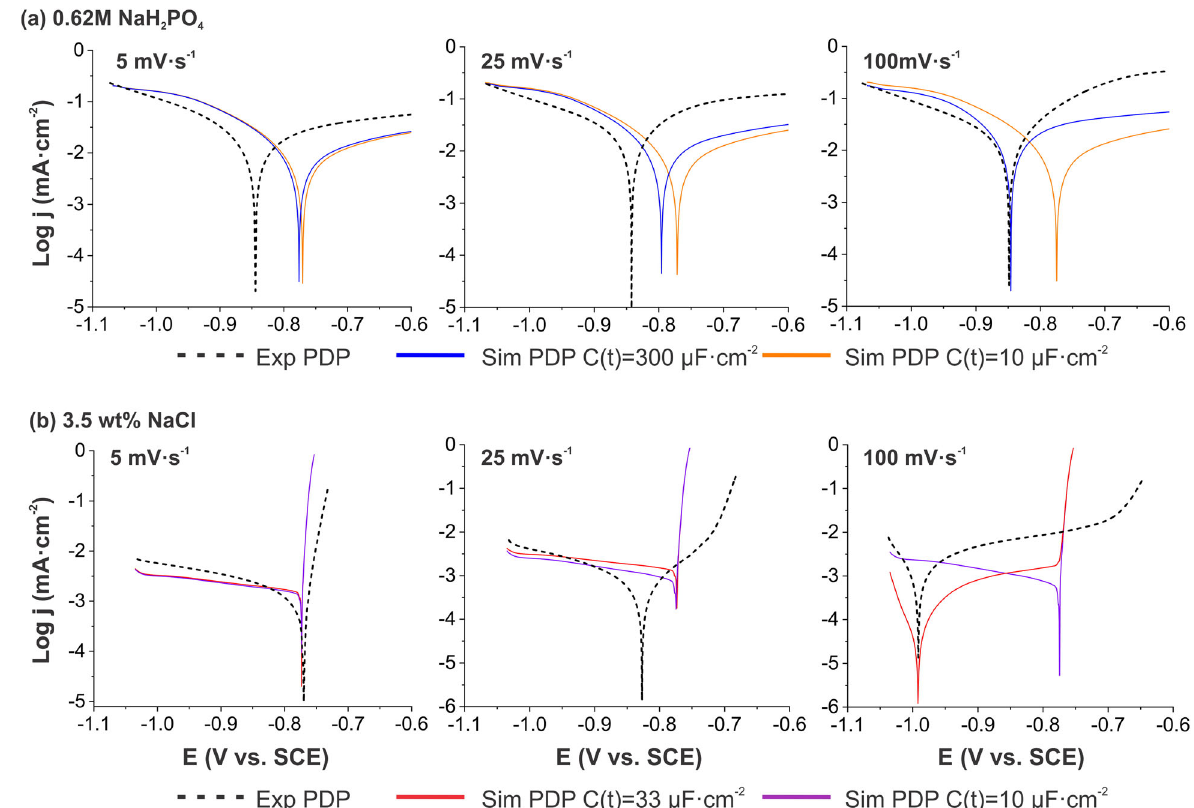
Fig. 4 PDP simulation with addition of capacitive current. Simulated PDP with the addition of a constant capacitive current, j cap . In ( a ) 0.62 M NaH 2 PO 4 and ( b ) 3.5 wt% NaCl.